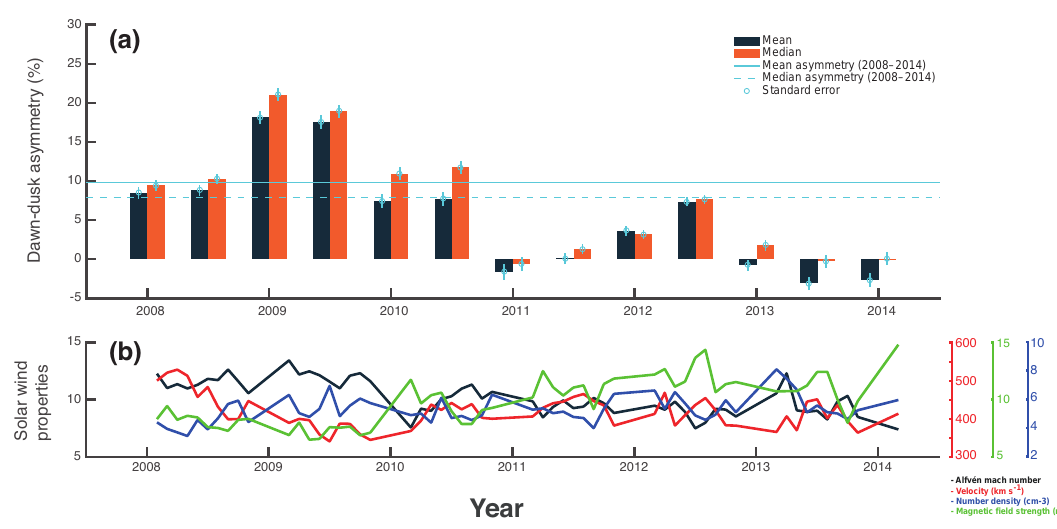
Figure 4. Dawn–dusk asymmetry of ion density in the dayside magnetosheath as a function of year from 2008 to 2014 (a) . The grey and orange bars in panel (a) represent the dawn–dusk asymmetry calculated using mean and median averages, respectively. The blue solid and dashed horizontal lines in the same panel show the mean and median dawn–dusk asymmetry for the entire interval between 2008 through 2014, respectively. The error bar limits are determined based on the maximum variation of the asymmetry based on the standard error about √ n . Panel (b) shows monthly mean averages of solar wind conditions over the same time period as in panel (a) the mean SEM = σ/